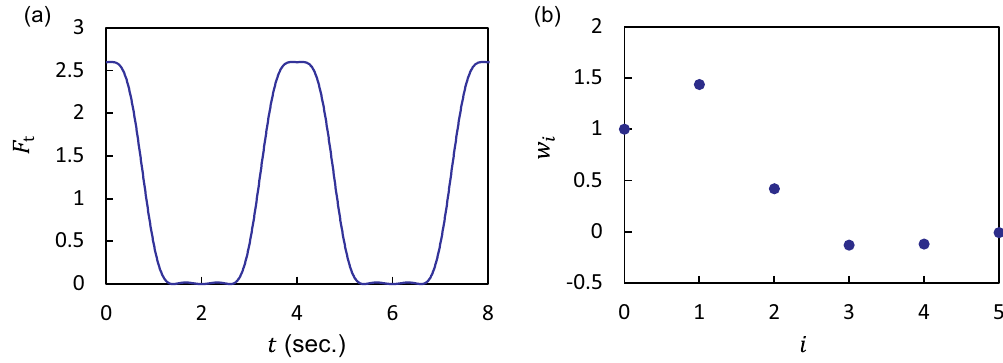
Figure 2. ( a ) Variation in time of F t , which is designed to be periodically switched acoustic radiation force. ( b ) Weight w i , allowing for the periodic switch. We set the frequency differential to δω/( 2 π) = 0.25 Hz and the number of the incident waves to N = 6 . The amplitudes are ˜ p 1 = 0.02854 , ˜ p 2 = 0.4314 , ˜ p 3 = 0.72149 , ˜ p = 0.51841 , ˜ p = 0.05564 , and ˜ p = 0.14385 . The phases are θ 4 5 6